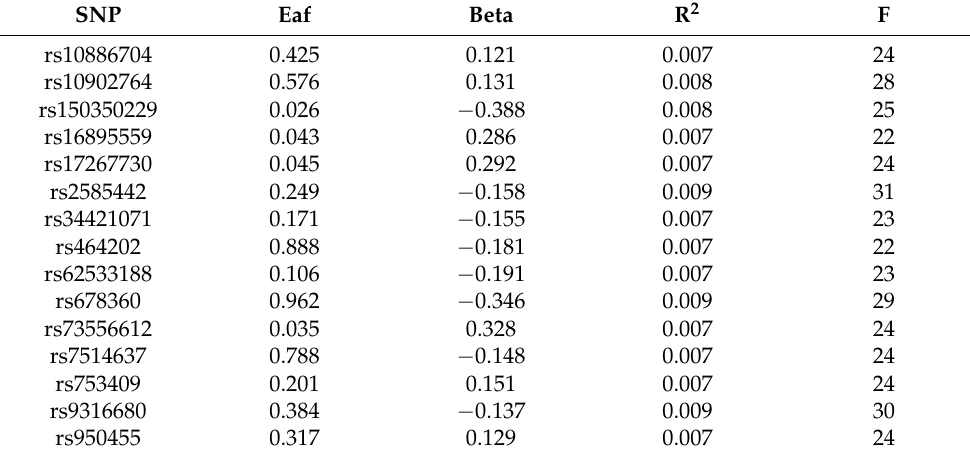
Table A3. The F statistics for SNPs strongly associated with parathyroid hormone.